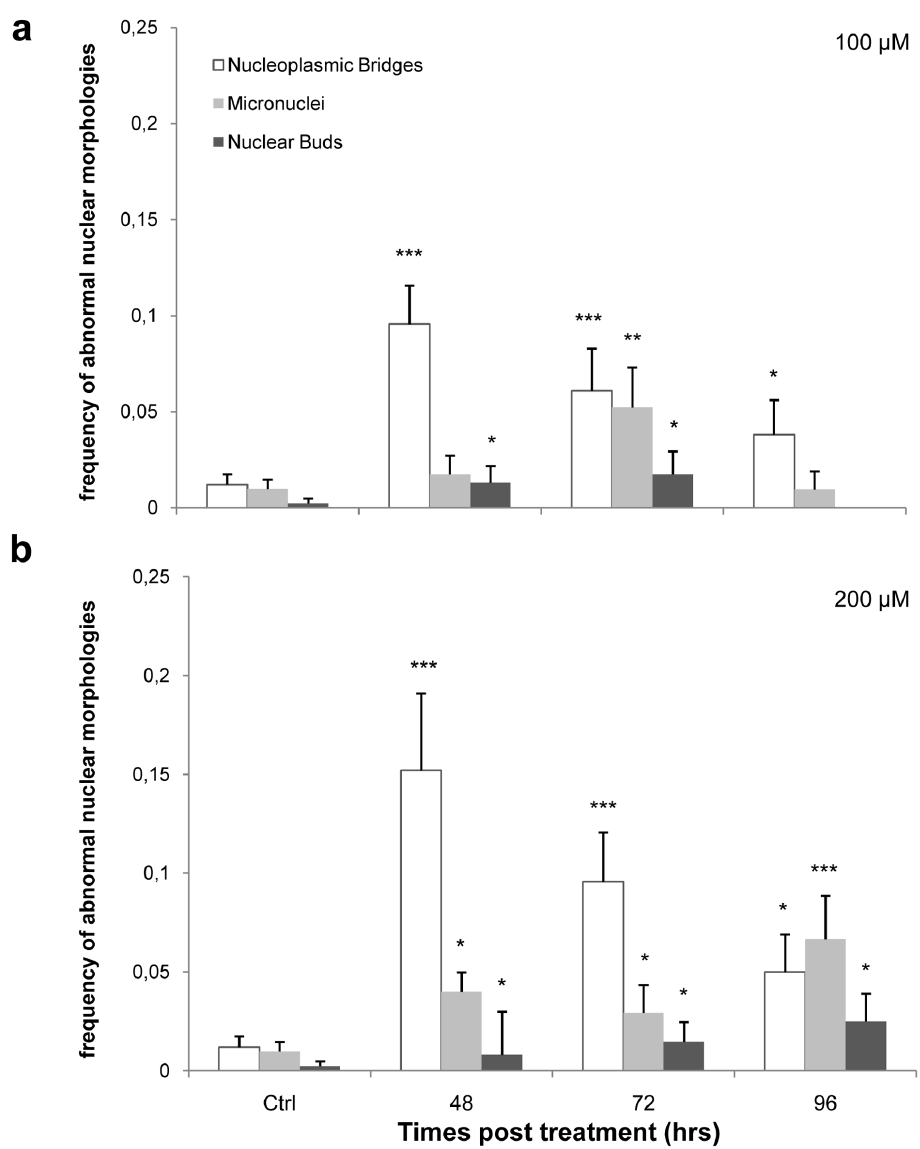
Figure 8. Abnormal Nuclear Morphologies. The different columns denote the abnormal nuclear morphologies analysed (NPBs, MN and NBUDs) at different times, compared to the control data. (a) Data obtained with 100 m M H 2 O 2 . We observed a significant increase of NPBs 48 hrs after treatment and a decrease at subsequent times. For MN and NBUD, we observed a fluctuating trend. (b) Data obtained with 200 m M H 2 O 2 . We again observed a significant increase of NPBs 48 hrs after treatment and a decrease with time until 96 hrs. The frequencies of MN and NBUDs exhibited a time-dependent increase up to 96 hrs. Error bars denote standard error. *p , 0.05; **p , 0.01; ***p , 0.001 by a binomial probability test.